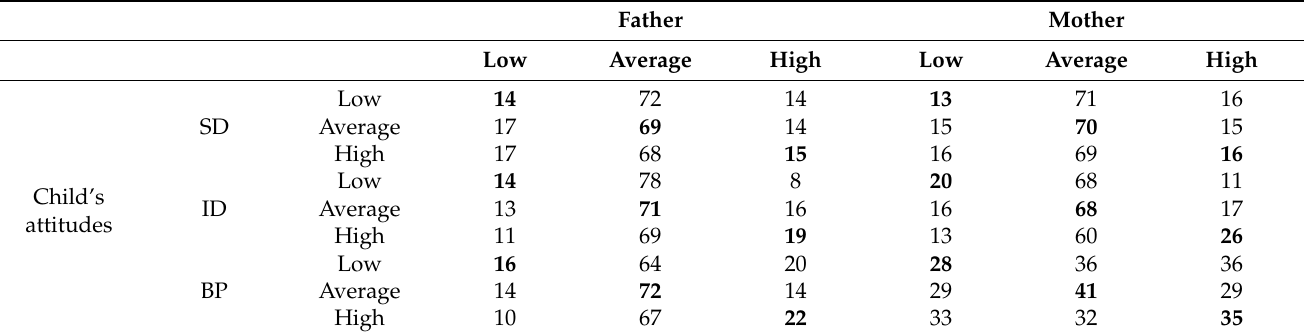
Table 3. Level of similarity between child’s and parents’ attitudes regarding each domain of disability. Father Mother Low Average High Low Average